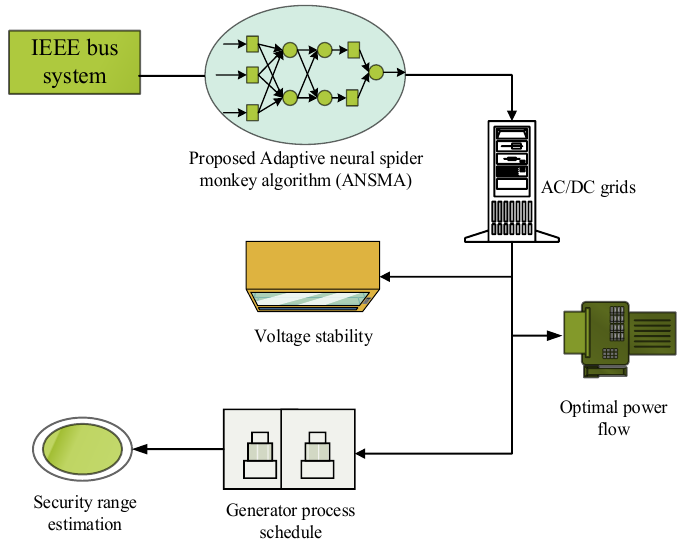
Figure 2. Diagram of proposed ANSMA.